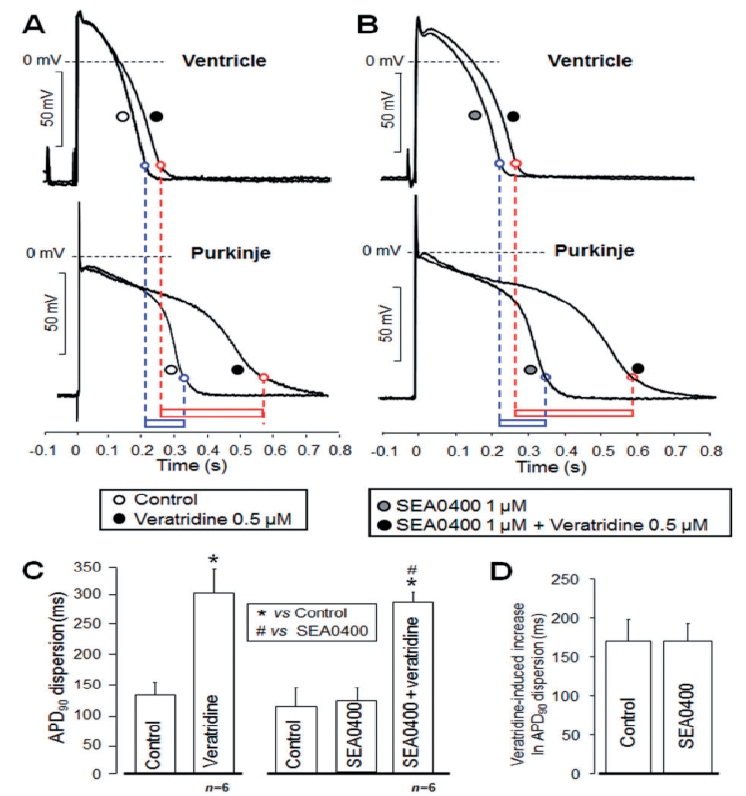
Figure 6. Selective NCX inhibition does not influence the ventricle–Purkinje action potential dispersion. ( A ): after control recordings (open symbol) 0.5 µM veratridine (filled symbol) was applied. ( B ) :